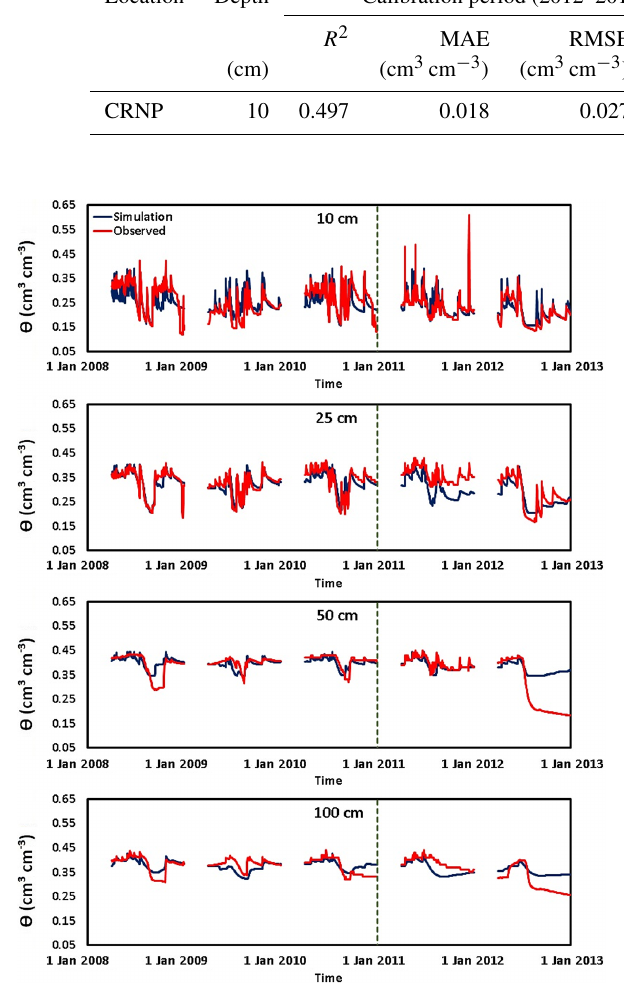
Figure 7. Daily observed and simulated SWC ( θ ) during the cali- bration (2008–2010) and validation (2011–2012) periods at the TP 1 location. See supplemental figures for other comparisons.